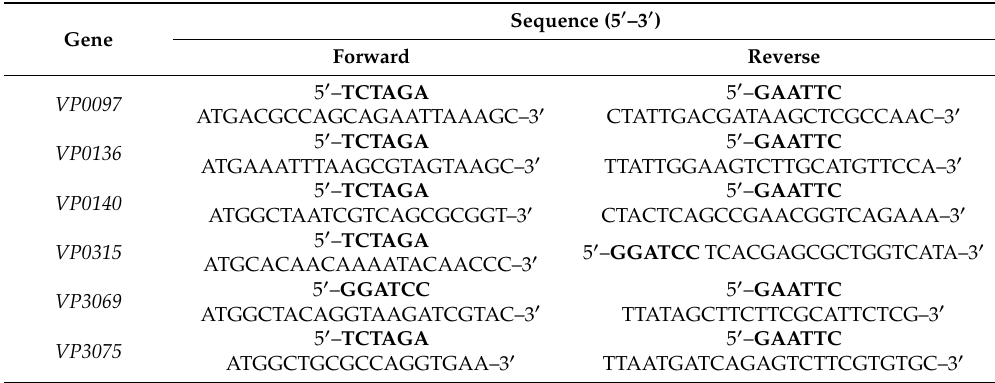
Table 2. Oligonucleotide primers for gene complementation.